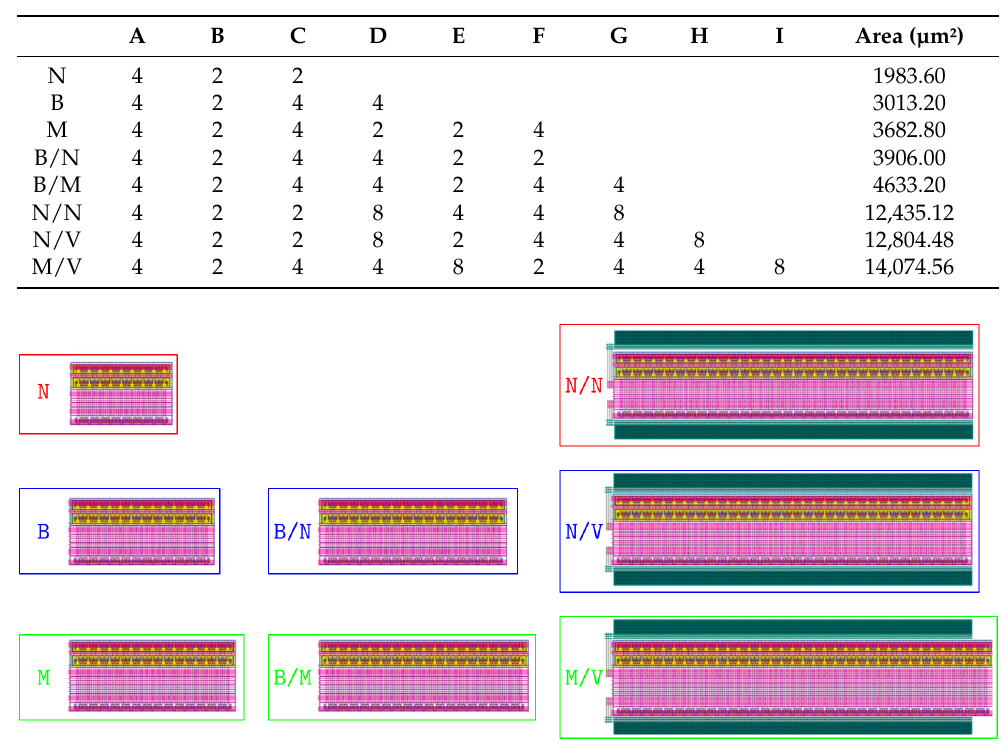
Table 2. OTA inverter cell multipliers.